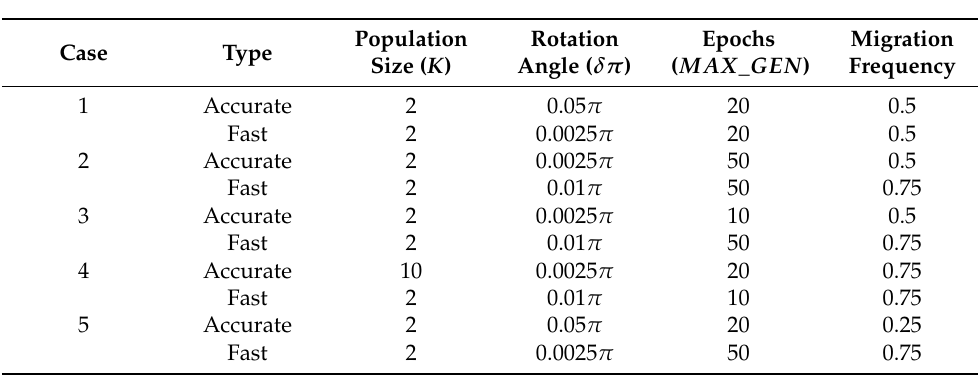
Table 4. Grid search